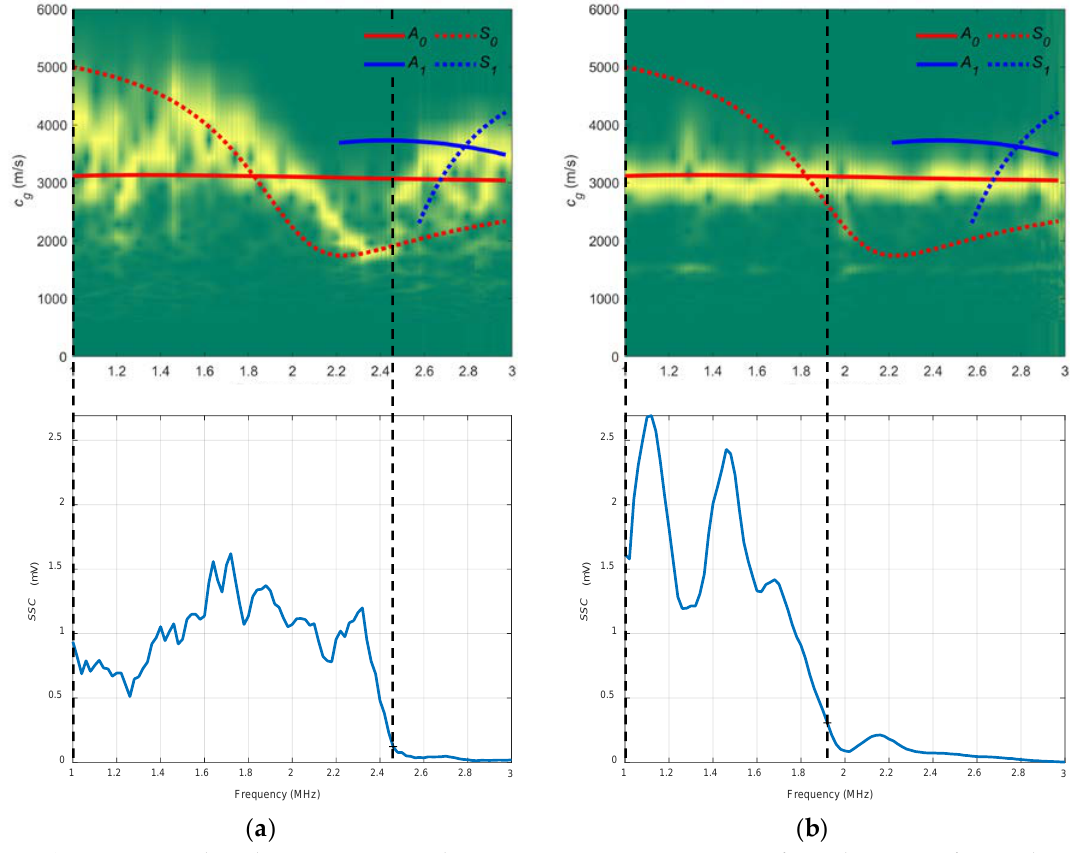
Figure 12. Combined spectrograms and system sensitivity curves ( SSC ) from the setup of conical containers to measure the stainless plate: ( a ) 20°; ( b ) 40°.